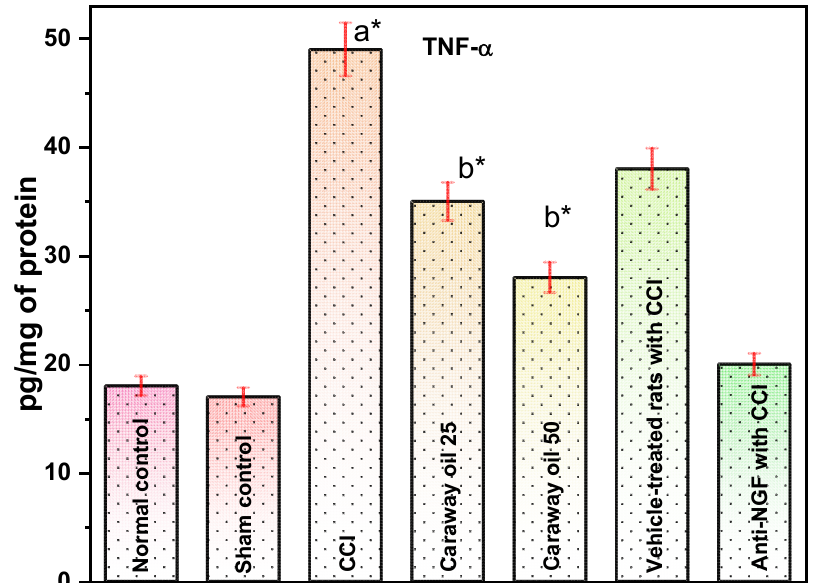
Figure 5. Effect of caraway oil on CCI-induced rise in TNF- α level in the sciatic nerve. It is represented as mean ± SEM; n = 6. a p ≤ 0.05 against sham control correspondent to the same day. b p ≤ 0.05 against CCI comparable to same day. * represents p -value ≤ 0.05.